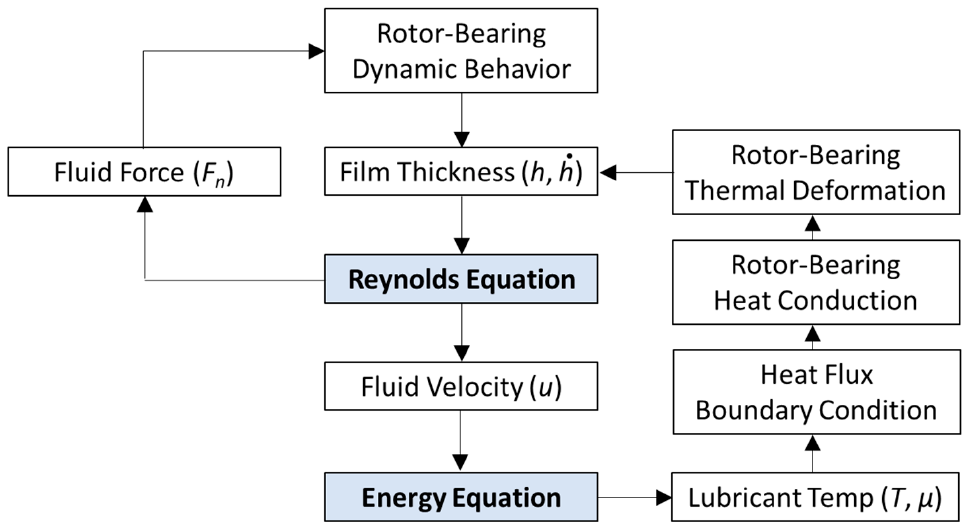
Figure 2. Thermo-hydro-dynamic lubrication model.